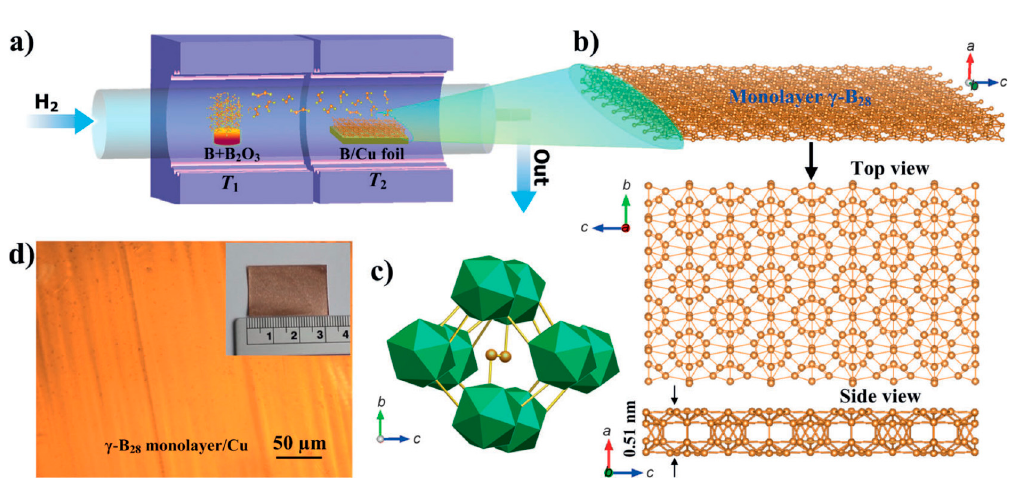
Figure 7. ( a ) Schematic diagram of the two-zone CVD furnace for two-dimensional (2D) γ -B 28 film. ( b ) Top and side views of the borophene monolayer. ( c ) The corresponding polyhedral structure of the basic unit cell in bc projection, in which boron atoms (orange spheres) form the dumbbells. ( d ) Optical image of a monolayer on Cu foil [23]. Copyright 2015, Wiley.